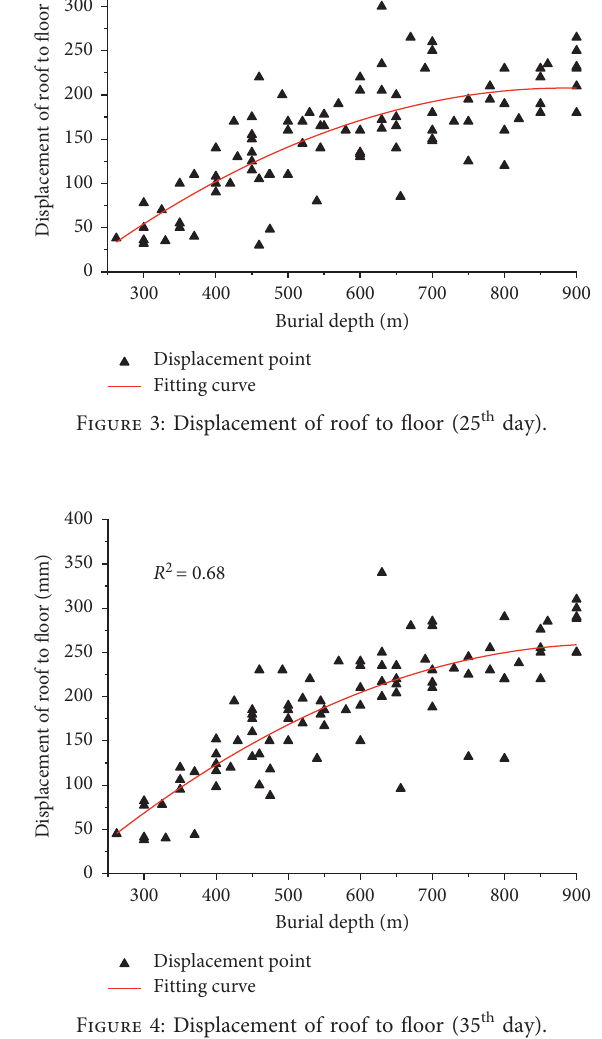
Figure 2: Displacement of roof to floor (15 th day).